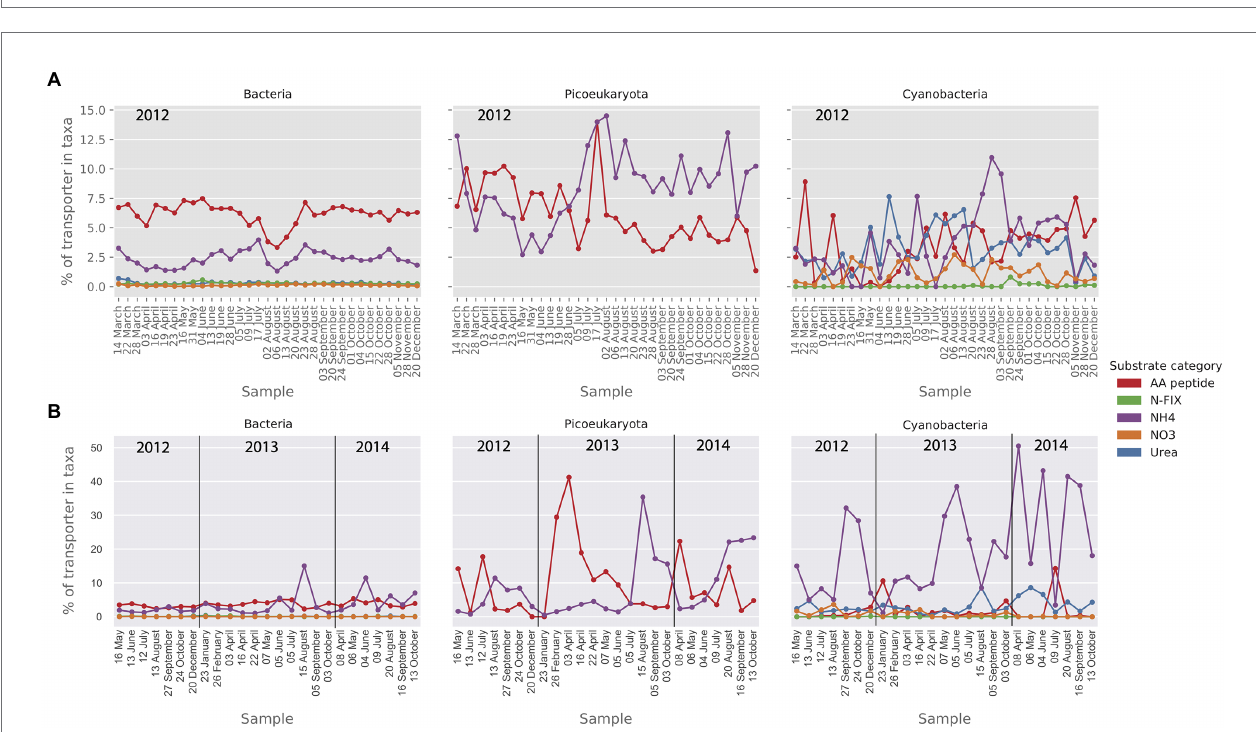
FIGURE 7 | Relative abundance (MG) and activity profiles (MT) of transporters for phosphate and phosphonate in (A) the metagenomic dataset and (B) the metatranscriptomic dataset. Gene abundances and transcripts are shown relative to the total of the transporters within each taxonomic group. Only transporters that make up at least 1% of the relative transporter abundance/activity in one or more samples are shown